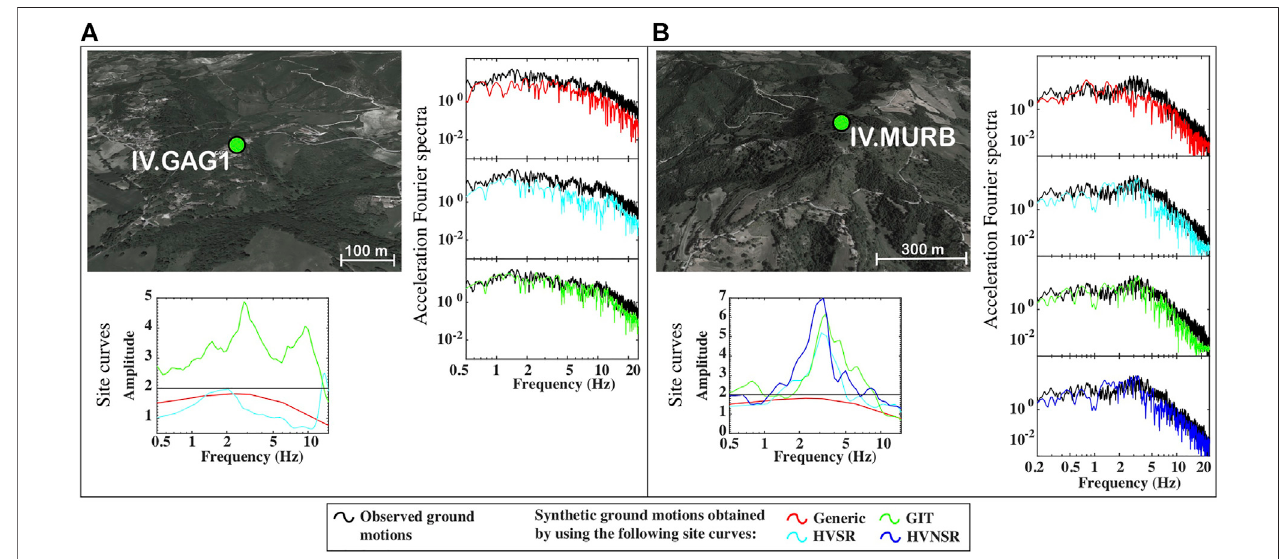
FIGURE6| SimulationresultsandrecordsoftheAmatriceearthquakeatstationsGAG1[panel (A) ]andMURB[panel (B) ],locatedontopographicirregularities.For each one, we show a digital elevation model to evince topography shape; the applied generic and empirical site curves at each station (consistently with Figure 2 );